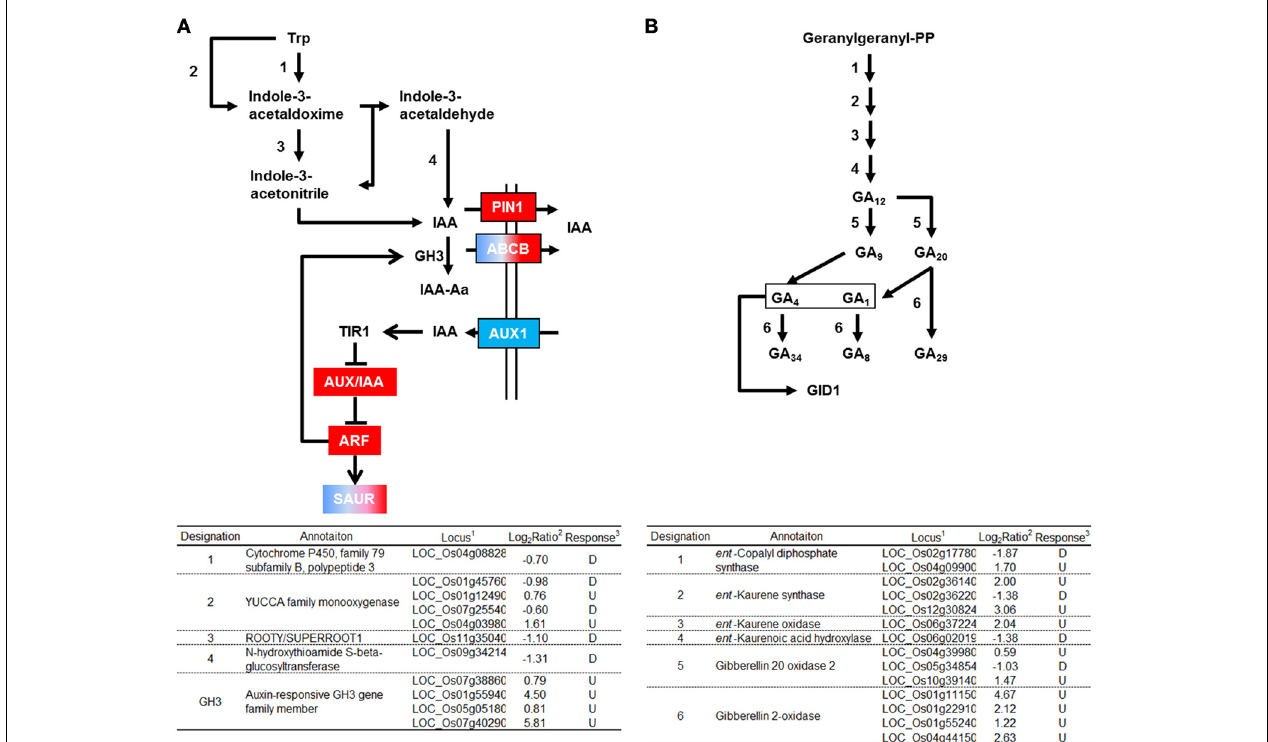
intensity in RTSV-infected plant/signal intensity in mock-inoculated plant), and 3 U (D): Significantly induced (suppressed) by RGSV infection. Boxes of red (or blue) indicate that the corresponding genes are predominantly induced (or suppressed). Boxes of red/blue indicate that the number of the corresponding genes induced was similar to that of suppressed genes. → : Reaction and translocation of substrate → : Positive signaling (cid:7) : Negative